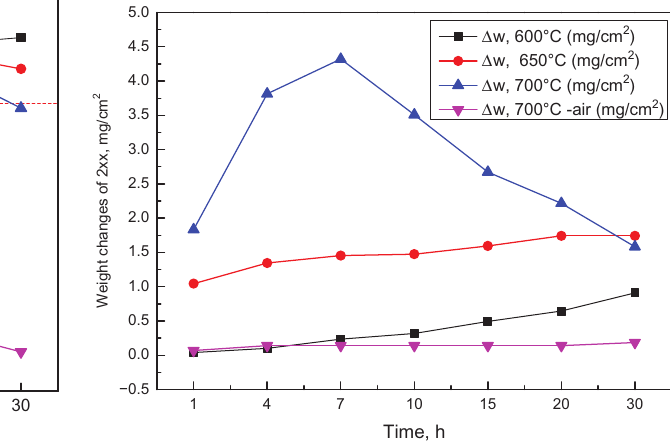
Figure 4: Weight changes during the corrosion process in KCl for four test materials and reference TP316 at 700°C.